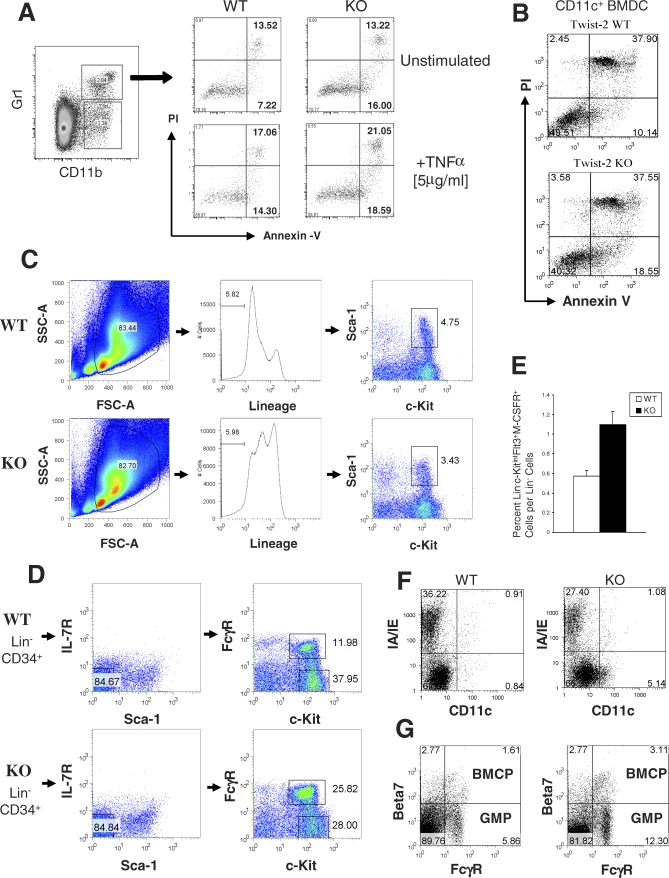
Increased Myeloid Progenitors in Twist-2–Deficient Mice(A) Flow cytometry of splenocytes cultured in complete medium and stimulated with TNFα (5 μg/ml) for 24 h. Cells were stained with CD11b, Gr-1, and Annexin-V antibodies and PI to determine relative apoptotic and necrotic populations from one of the representative repeated experiments.(B) Flow cytometry of BMDC derived from Twist-2 KO mice or WT littermates at day 10 of culture from one of the representative repeated experiments. Cells were stained with CD11c and Annexin-V antibodies and PI.(C) Flow cytometric analysis showing a subtle decrease in Lin−c-Kit+Sca1+ HSC compartment in Twist-2 KO mice. Results are representative of four independent experiments.(D) Flow cytometric analysis showing a significant increase in Lin−IL7R−Sca1−c-Kit+CD34+FcγR+ GMP population in BM of Twist-2 KO mice representative of six independent experiments.(E) Flow cytometric analysis showing a significant increase in Lin−c-KitintFlt3+M-CSFR+ DC precursors in the BM of Twist-2 KO mice. Representative of two independent experiments. Error bars indicate SD.(F and G) Twist-2 KO mice have increased IA/IE−CD11c+ DC precursors ([F]) in the peripheral blood and increased Lin−IL7R−c-Kit+FcγR+Beta7high BMCP as well as Lin−IL7R−c-Kit+FcγR+Beta7−/lo GMP in Twist-2 KO spleen (G). Results are representative of three independent experiments.